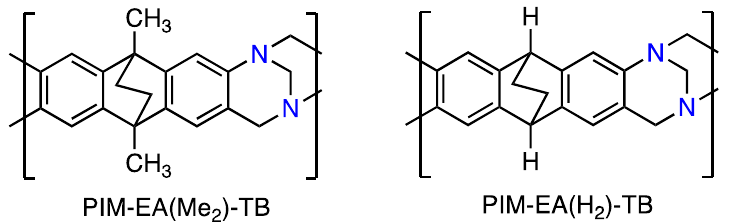
Figure 2. The chemical structure of PIM-EA(Me 2 )-TB and PIM-EA(H 2 )-TB.